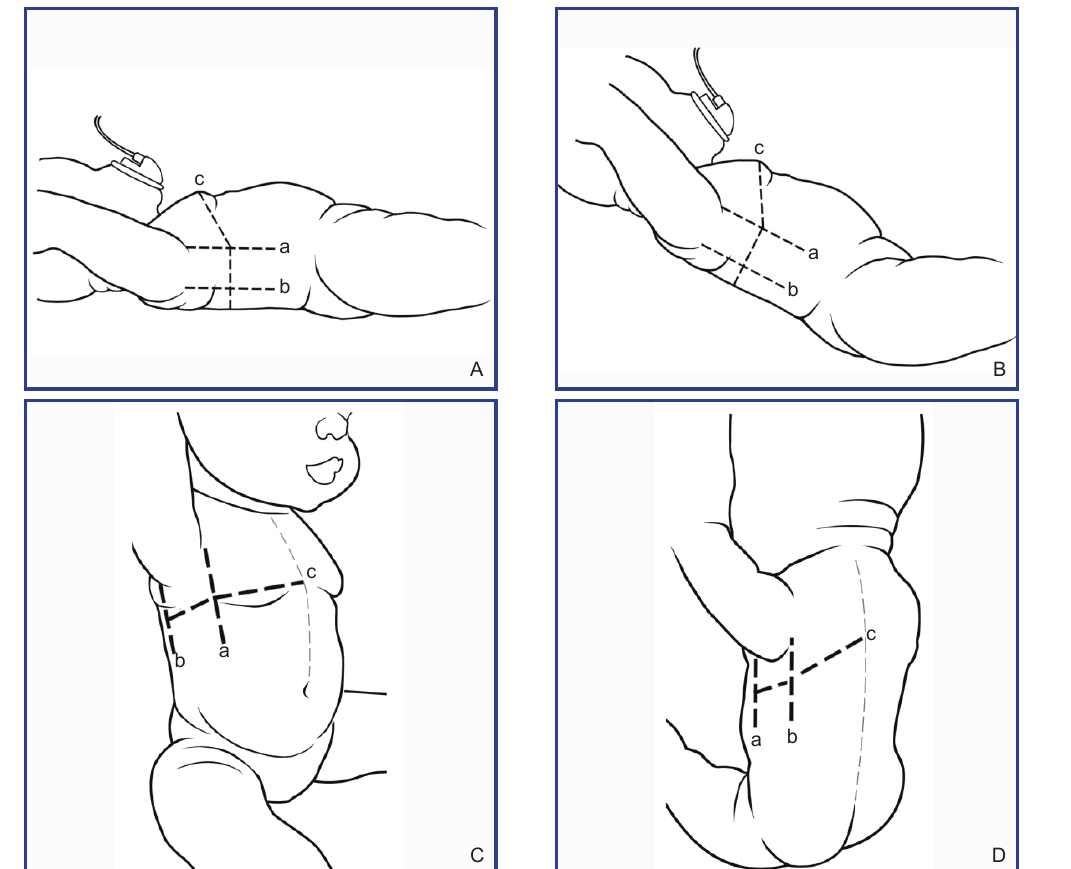
Figure 1 Position and body surface partition. (A) Supine position; (B) Semi-recumbent position; (C ~ D) Sitting position. a, anterior axillary line; b, posterior axillary line; c, the connecting line between the two nipples. Named by L/R-A/L/P-U/L method: the chest surface is divided into left (L) and right (R), which are divided into anterior (A), lateral (L) and posterior (P) zones by four lines, and the above three parts are divided into upper (U) and lower (L) parts by horizontal line connecting